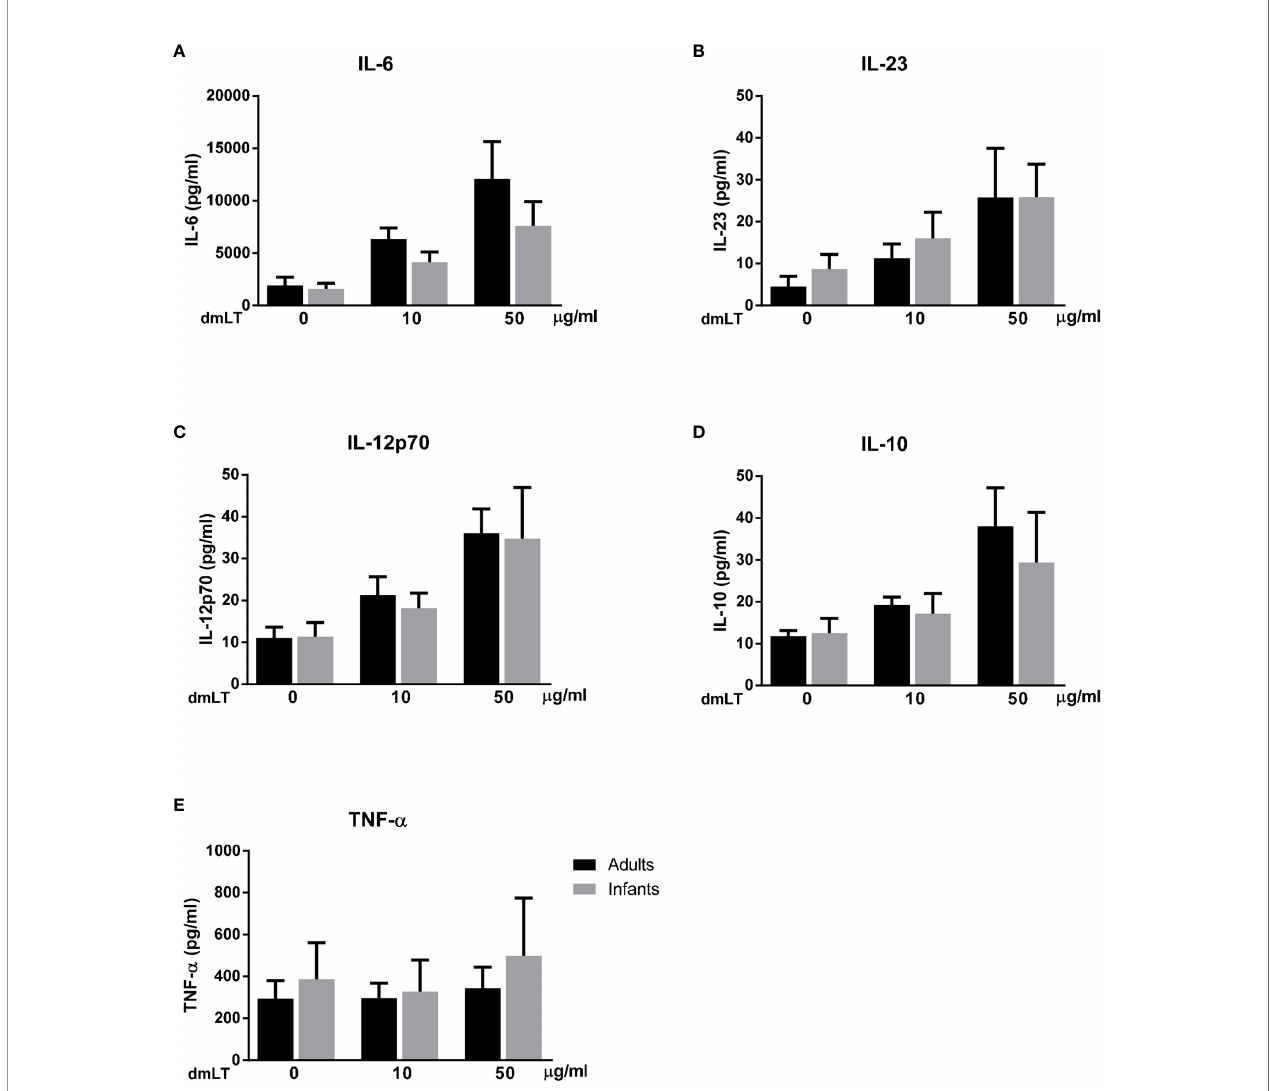
FIGURE 7 | Production of IL-6, IL-23, IL-12p70, IL-10 and TNF- a from PBMCs stimulated with dmLT. Cytokine concentrations in cultures with PBMCs from adults (n = 5) and infants (n = 5) stimulated with increasing concentrations of dmLT (10 and 50 µg/ml). Bars represent mean with SEM of concentrations of (A) IL-6, (B) IL- 23, (C) IL-12p70, (D) IL-10 and (E) TNF- a in culture